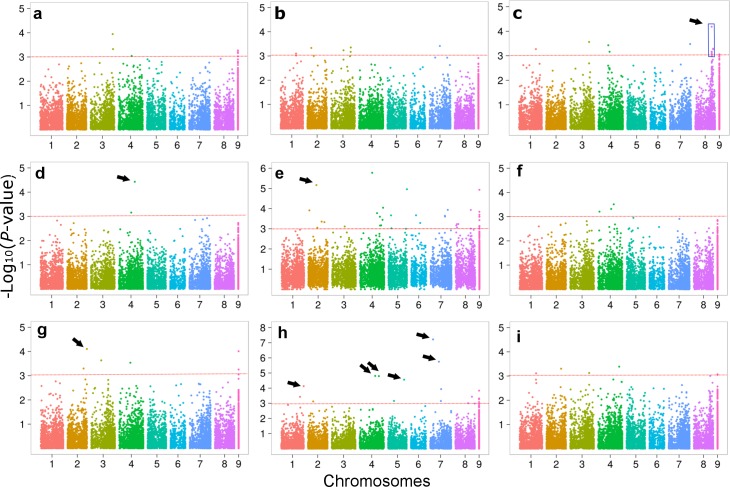
Manhattan plots for genome-wide association of alfalfa forage quality traits with SNP markers.Traits are: (a), leaf-to-stem ratio; (b), leaf neutral detergent fiber; (c), leaf acid detergent lignin; (d), leaf crude protein; (e) leaf in vitro NDF digestibility at 24 hours; (f), stem neutral detergent fiber; (g), stem acid detergent lignin; (h), stem crude protein; (i) stem in vitro NDF digestibility at 24 hours. Red lines (positioned at 3.0) indicate the minimum threshold to select significant markers (listed in S1 Table). The blue box in (c) highlights a portion of chromosome 8 with high concentration of significant associations. Arrows highlight major associations whose definition is given in Table 3. Marker positions were based on the reference genome of M. truncatula Mt4.0v1 (SNPs not aligning were placed on a fictitious chromosome 9).